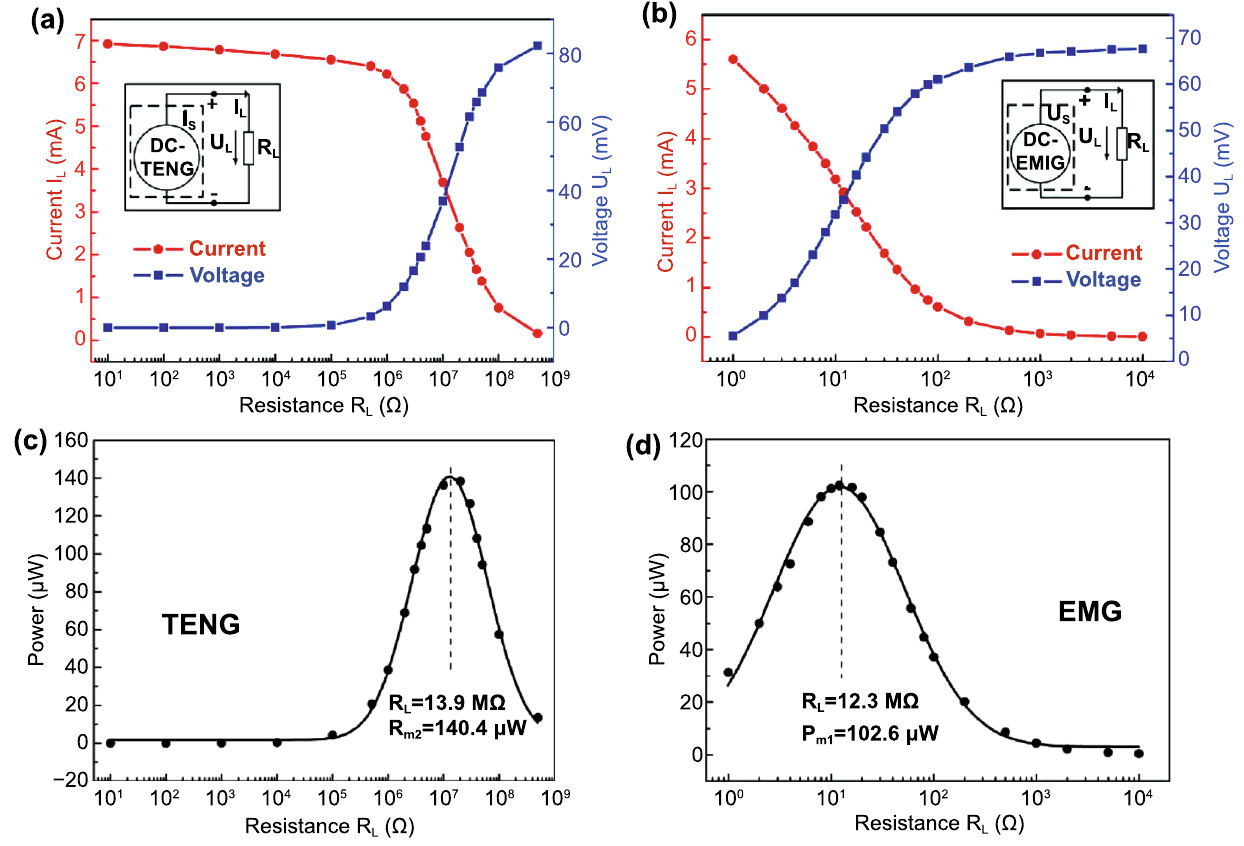
Fig. 5 Typical dependence of the harmonic output voltage amplitude, current amplitude and average power of a TENG and EMG with the value of an external load resistance and Norton equivalent circuits. a TENG voltage and current; b EMG voltage and current. c TENG power; d EMG power. As depicted, the TENG yields high output voltage and low current, while the EMG yields high output current and low voltage. Repro- duced with permission from Ref. [63]. Copyright 2014, Advanced Materials. (Color figure